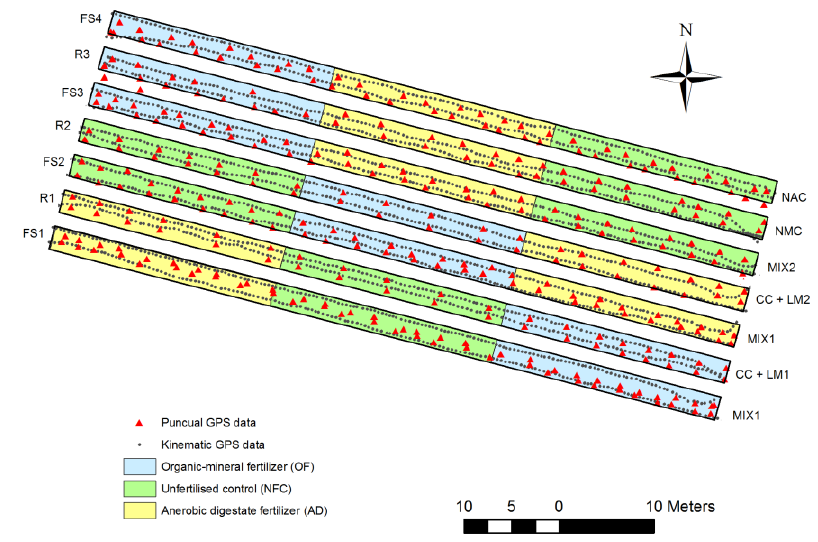
Figure 2. The experimental device with the sampling location based on a kinematic (black points) and punctual (red triangles) approach, along the four flat strips (FS) and the three ridges (R) split in the three different fertilizations. For each ridge, the cash crop (CC) was cultivated with different types of legume LM (LM1 and LM2) and with no living mulch control (NMC). For each FS, the ASC mixtures were cultivated (MIX1, MIX2) and a no ASC control (NAC) was also included.